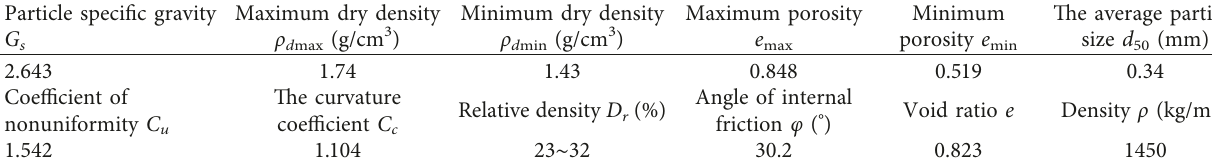
Table 1: Physical properties of sand.